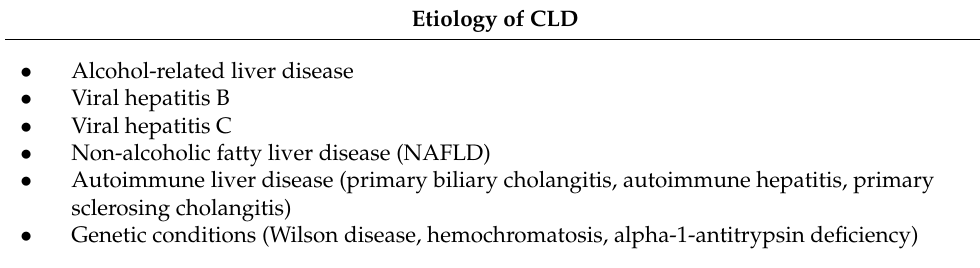
Table 2. The etiology of chronic liver disease [4,46].